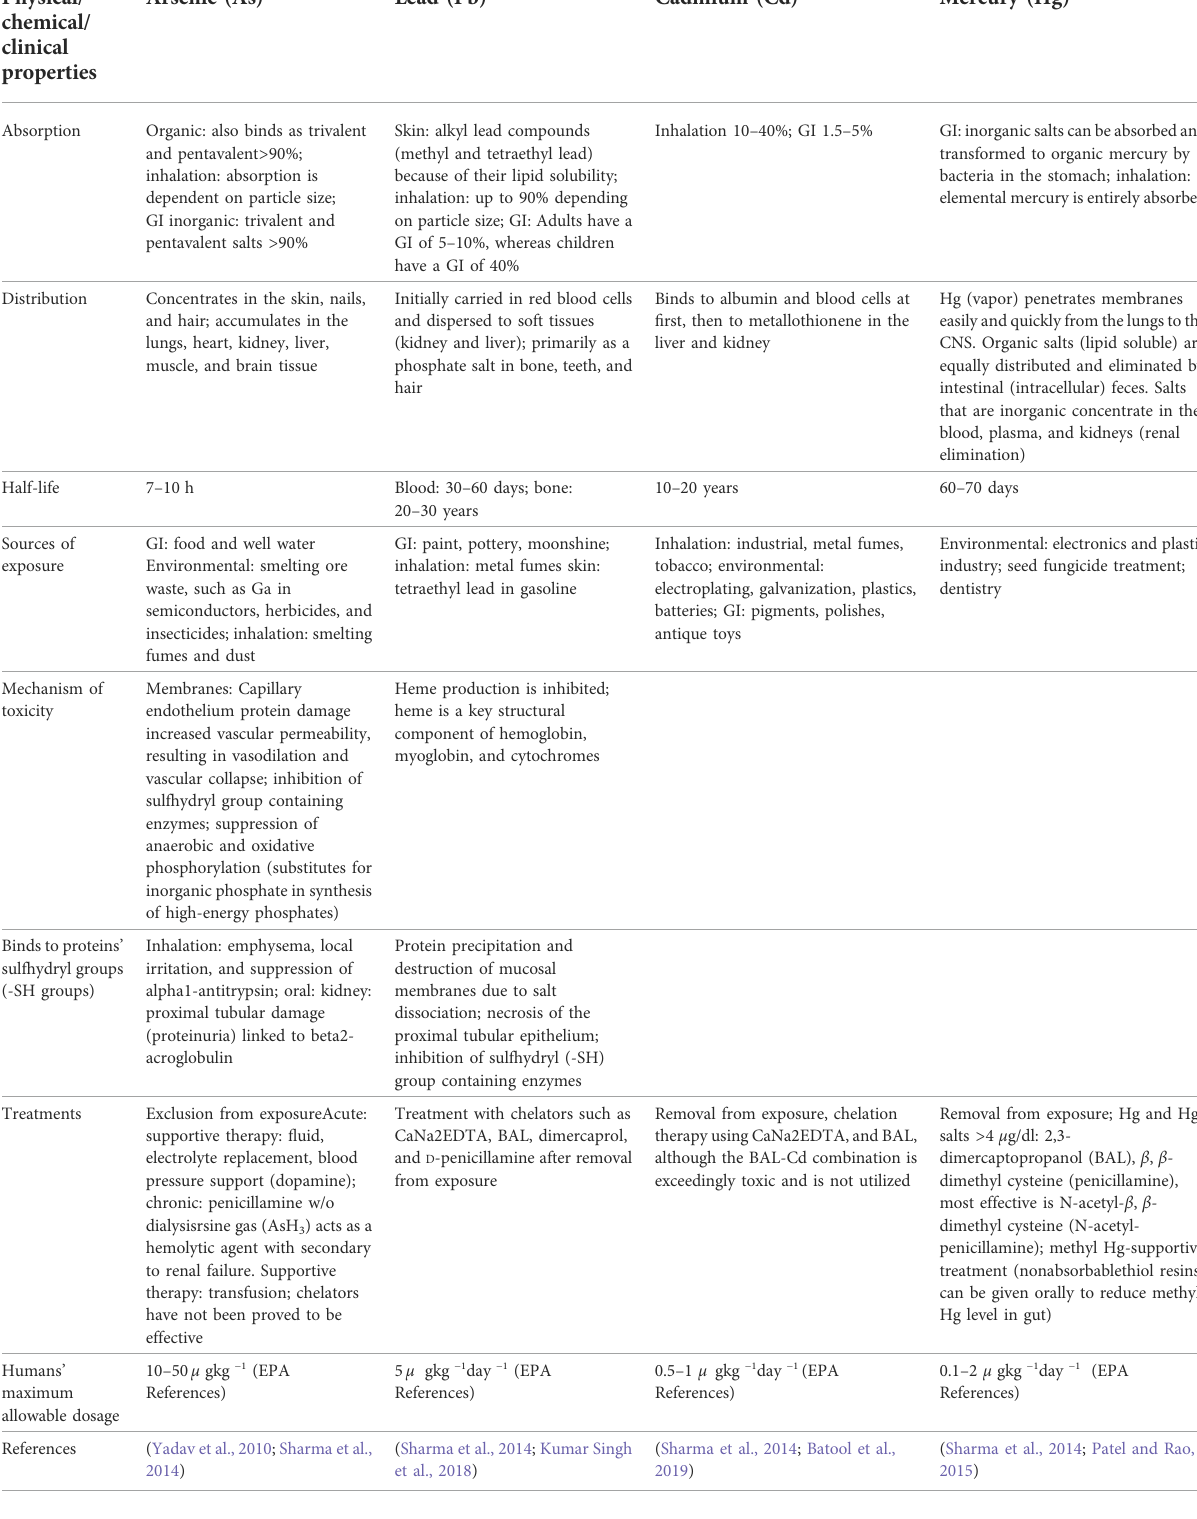
TABLE 1 Some heavy metal-induced Alzheimer ’ s disease-associated molecular objects. Physical/ chemical/ clinical